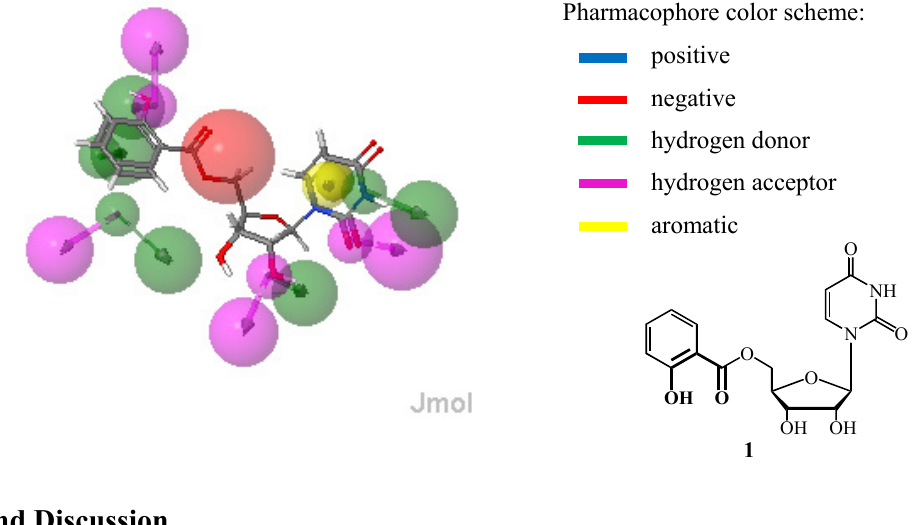
Figure 1. Pharmacophore of β 4GalT I (PDB ID 1TVY) and aligned ligand 1 pose. Pharmacophore color